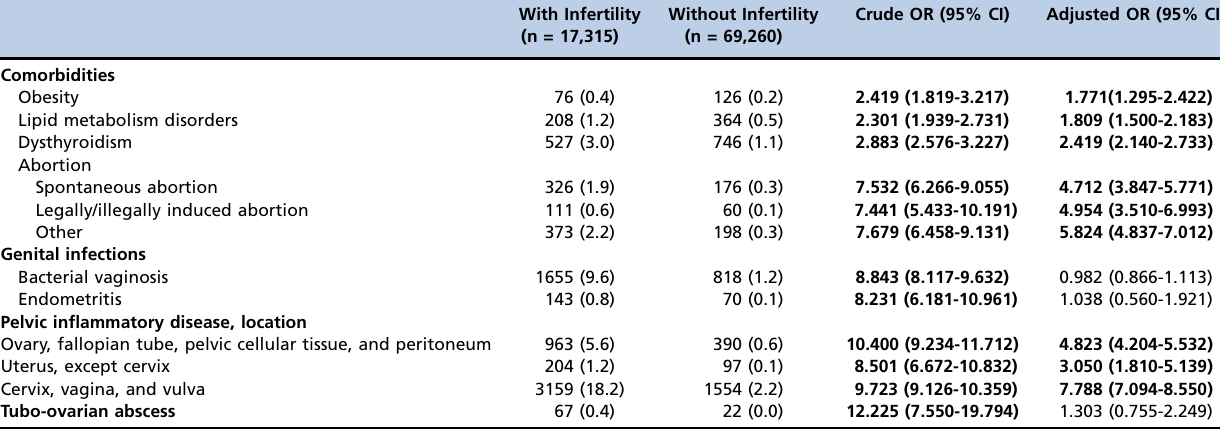
Table 2 - Risk factors for infertility in women aged p 40 years.